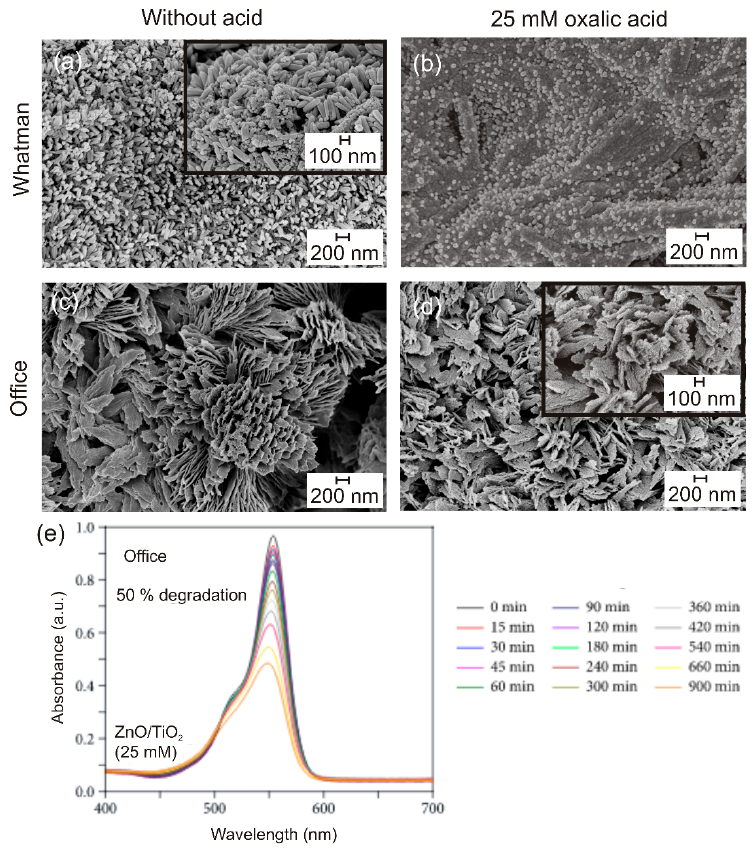
Figure 14. ZnO/TiO 2 heterostructures grown on Whatman and Office papers having TiO 2 synthesized without acid and with 25 mM of oxalic acid ( a – d ). The inset in ( a ) magnifies the heterostructure, while the inset in ( d ) evidences the surface modification with oxalic acid. ( e ) Rhodamine B photodegradation under UV light of the heterojunction grown on office paper and represented in ( d ) [12]. Reproduced with permission of Hindawi [12].